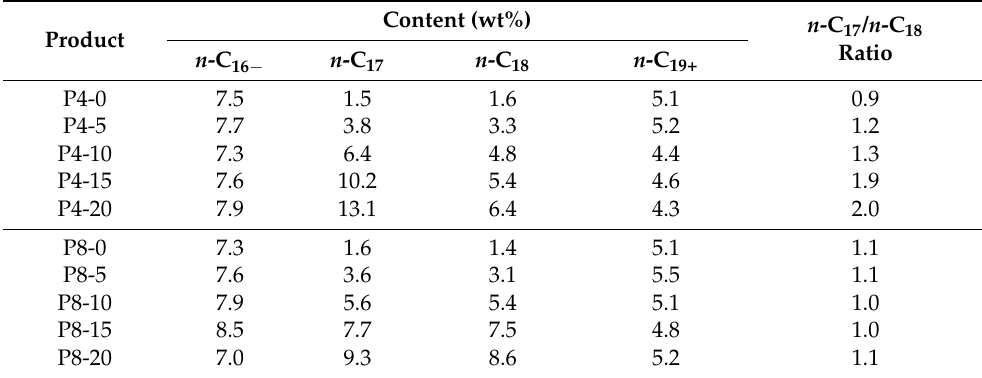
Figure 2. The content of SHCs ( A ) and MAHs ( B ) in the feedstocks (F) and the hydrotreated products (pressure of 4 and 8 MPa). Table 3. The content of n -alkanes in the liquid